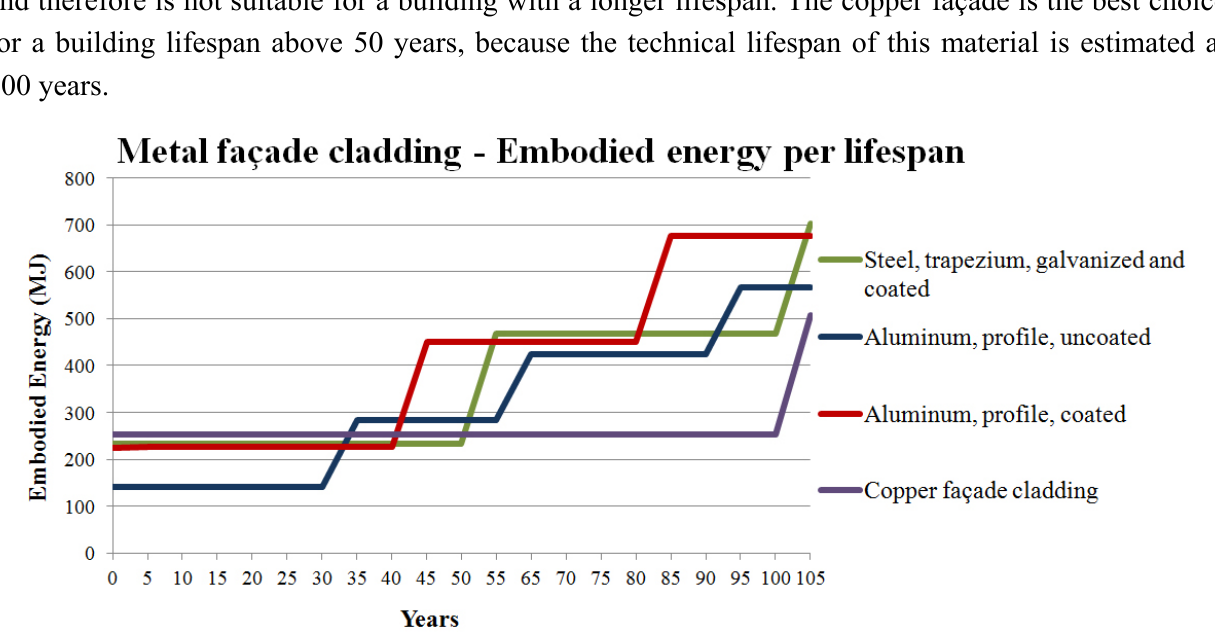
Figure 1. Material comparison of metal façade cladding for 1 m 2 of façade. The steel façade (galvanized and coated) needs to be replaced every 50 years, the aluminum profile uncoated every 30 years, the aluminum coated profile every 40 years and the copper façade cladding every 100 years, according to the NIBE database